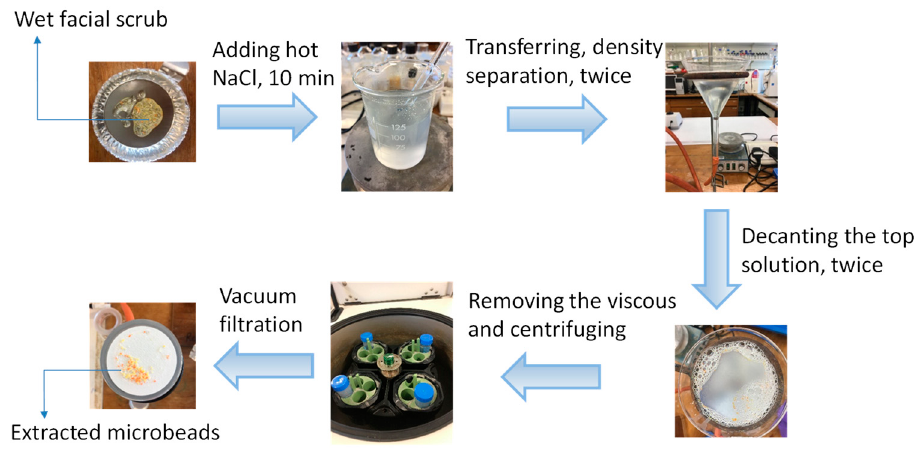
Figure 1. Schematic diagram of the whole process to extract microbeads from facial scrub for use in the exposure studies. More details are given in Section 2.1.